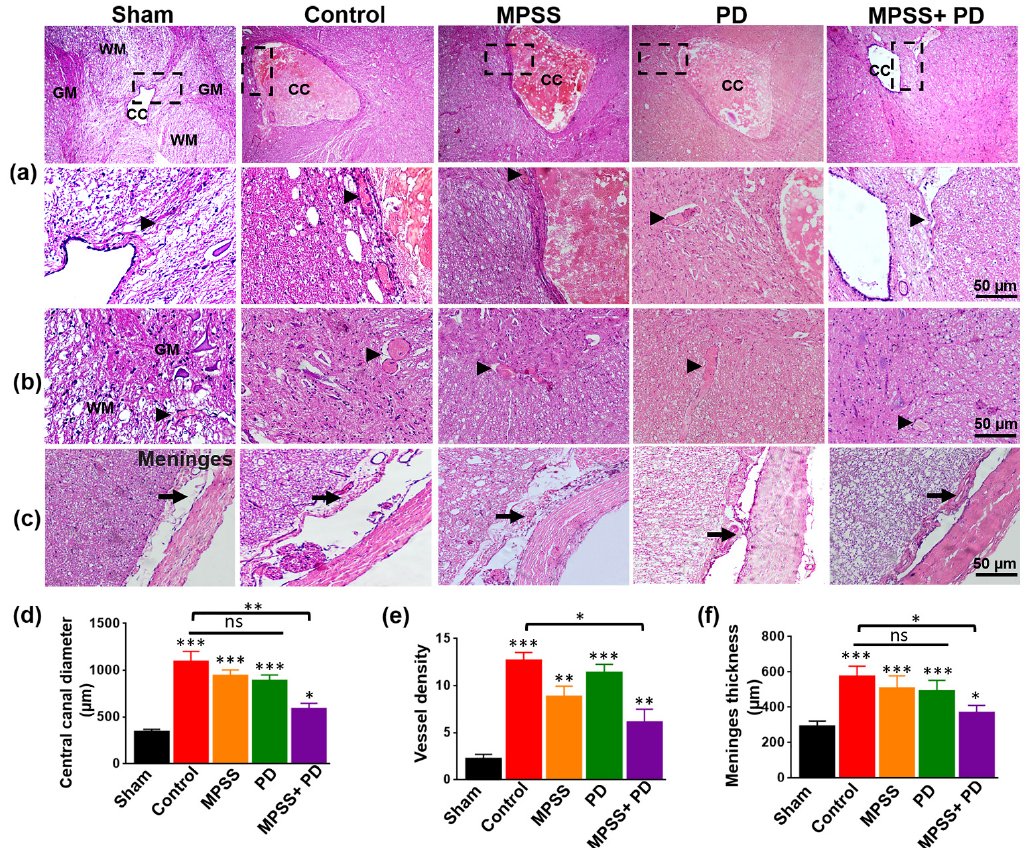
Figure 5. Histopathological findings of control, MPSS, PD150606, and MPSS+PD150606 groups 8 weeks post SCI. ( a – c ) Representative microscopy images of the dog’s spinal cord in the indicated groups after experimentally induced SCI, stained with H&E. ( a ) Gay matter (GM), white matter (WM) and the central canal (CC) of the spinal cord are shown in low and high magnification (rectangular). ( b ) Neuronal cell bodies and glial cells from the ventral horn, and ( c ) spinal cord meninges are shown. Compared to the sham group, all groups showed severe spinal canal congestion, hemorrhage with many congested blood capillaries (arrows heads), infiltration of microglial cells, neuronal loss and damage, and an apparent increase in spinal meninges thickness (arrows). However, the combination group of MPSS and PD150606 revealed less hemorrhaging, fewer inflammatory responses, and congested blood capillaries compared with other groups. Scale bare = 50 µ m. ( d ) Quantitative analysis of the average central canal diameter, ( e ) Vessel density (vessels/0.5 mm 2 ), and ( f ) meninges thickness, in indicated groups. Ten images from each group were used for data quantification. Data are presented as the mean ± SD. * indicates a significant difference ( p < 0.05), ** indicates a significant difference ( p < 0.01), *** indicates a significant difference ( p < 0.001), and ns indicates